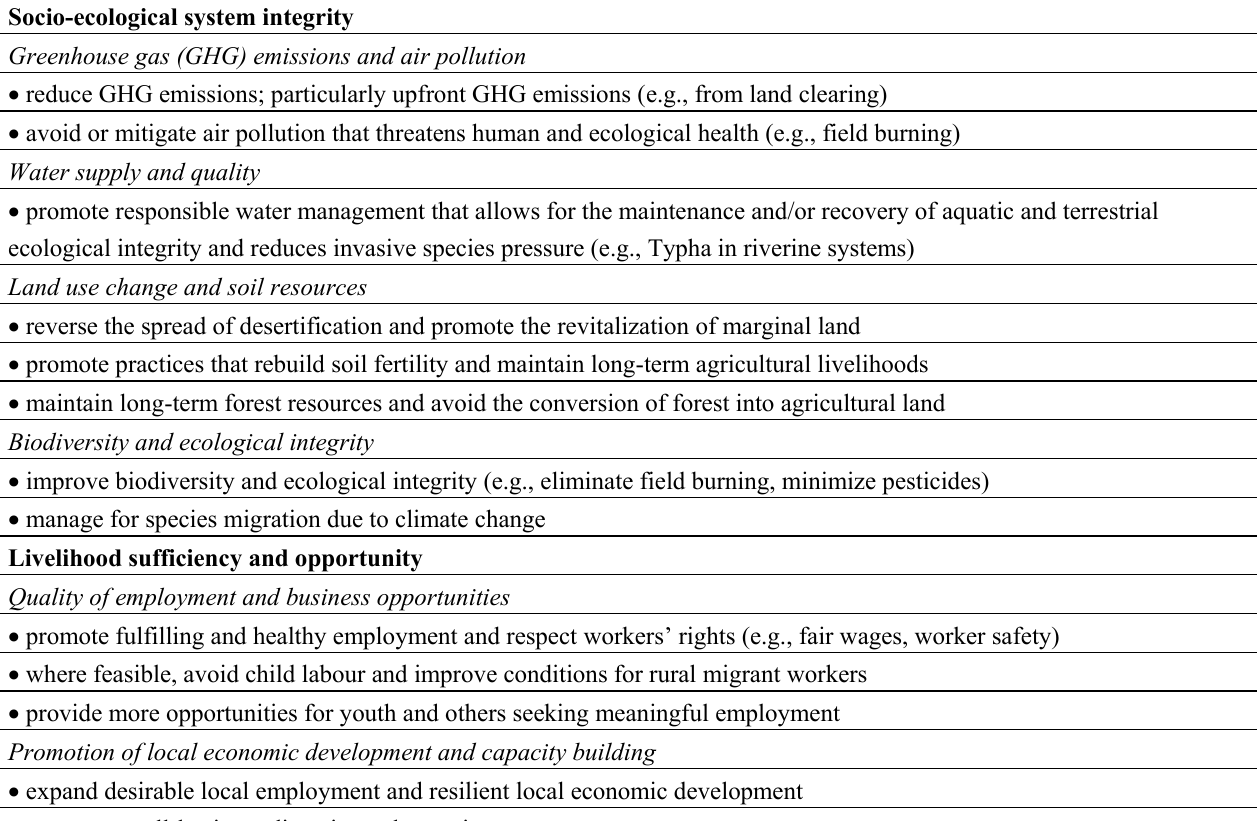
Table 2. Proposed sustainability criteria for energy-agriculture applications in Senegal. Socio-ecological system